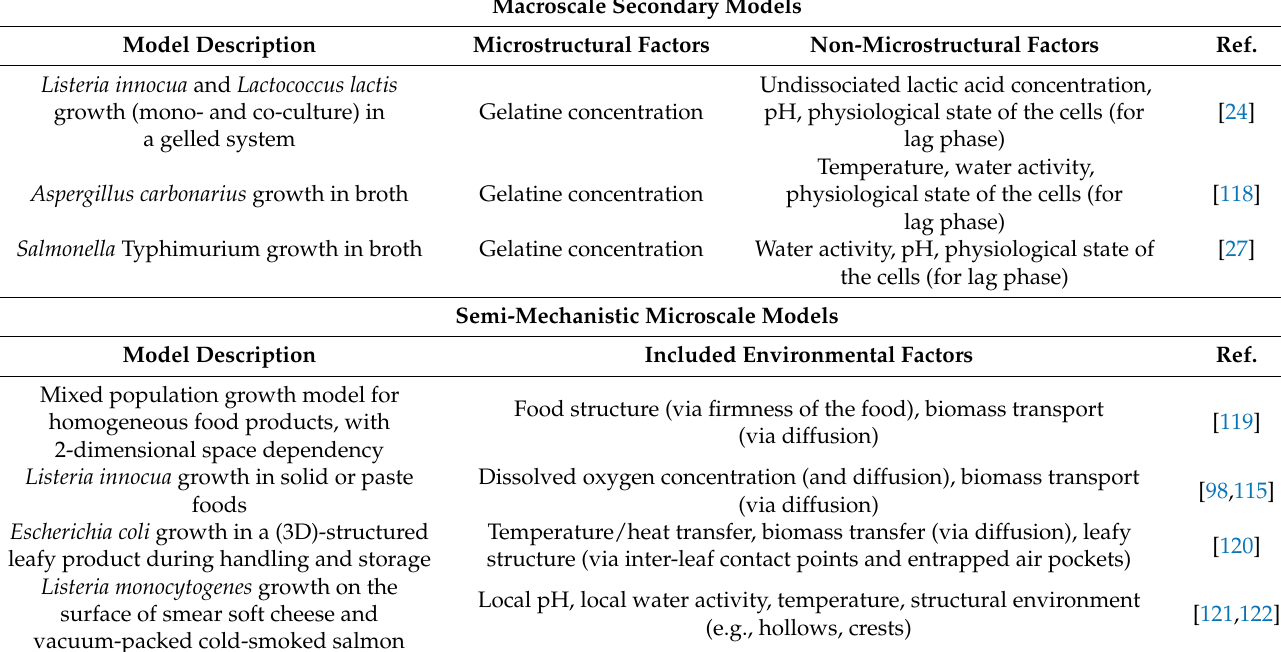
Table 2. Overview of the most relevant growth models incorporating food